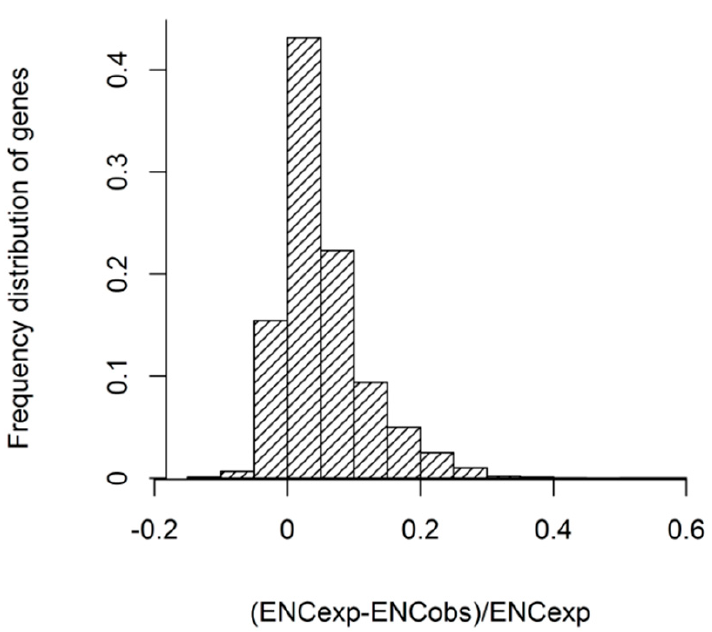
Figure 4. Frequency distribution of the ENC ratio.